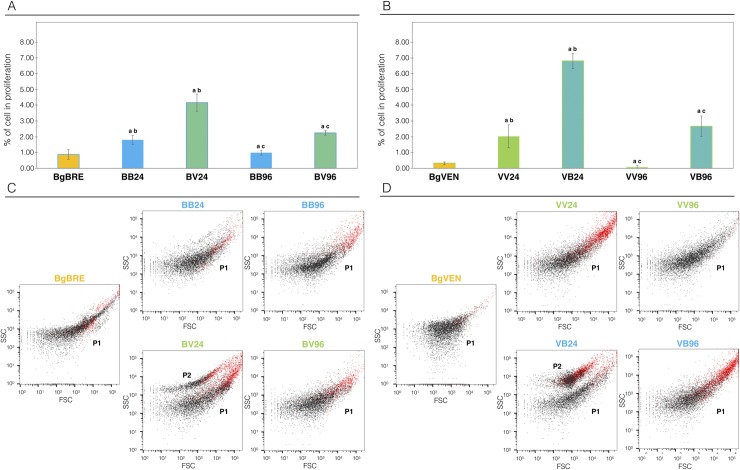
Flow cytometry analyse of the hemocyte response in sympatric and allopatric interactions.A) Flow cytometry was used to count in vivo EdU-labeled hemocytes at 24 h and 96 h after infection in sympatric and allopatric interactions. A total number of hemocytes of n = 10,000were recoveredfor6 biological replicates of 3 snails. Control naïve snails (BgBRE, yellow) were compared to those subjected to the sympatric interaction (BB, BgBRE/SmBRE, blue) or an allopatric interaction (BV, BgBRE/SmVEN, green). B) The experiment described in A was repeated using the BgVEN snail strain. Control naïve snails (BgVEN, yellow) were compared to those subjected to the sympatric interaction (VV, BgVEN/SmVEN, green) or an allopatric interaction (VB, BgVEN/SmBRE, blue). C) FSC (forward-scattered light, representing cell size) and SSC (side-scattered light, representing cell granularity) circulating hemocyte patterns in BgBRE snails under the naïve condition (yellow) or 24 h and 96 h after infections in sympatry (BB24/96, BgBRE/SmBRE, blue) or allopatry (BV24/96, BgBRE/SmVEN, green). D) FSC and SSC circulating hemocyte patterns in BgVEN snails under the naïve condition (yellow) or 24 h and 96 h after infections in sympatry (VV24/96, BgVEN/SmVEN, blue) or allopatry (VB24/96, BgVEN/SmBRE, green). The red dots correspond to EdU-positive hemocytes. Between-group differences in the percentage of proliferation were tested using the Mann-Whitney U-test, with statistical significance accepted at p<0.05. The “a” indicates a significant difference between the naïve and infective condition, “b” indicates a significant difference between the infective conditions at 24h, and “c” indicates a significant difference between the infective conditions at 96h.